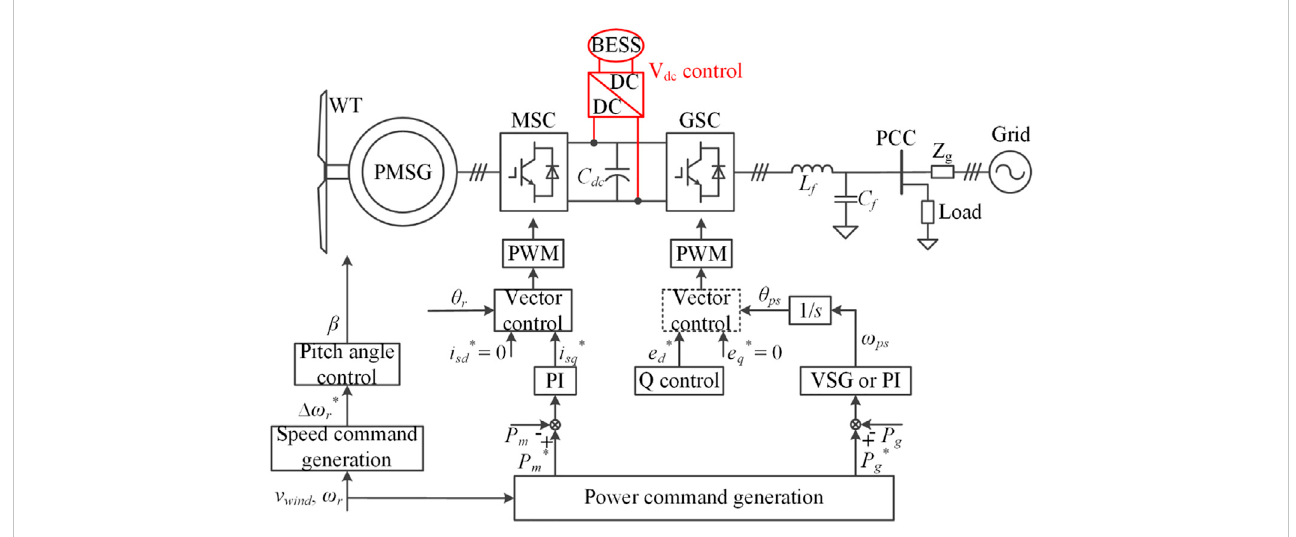
FIGURE 7 GFM control scheme of type-4 wind generator with battery energy storage system connected to the dc-link (Ma et al., 2016; Ma et al., 2017; Fang et al.,